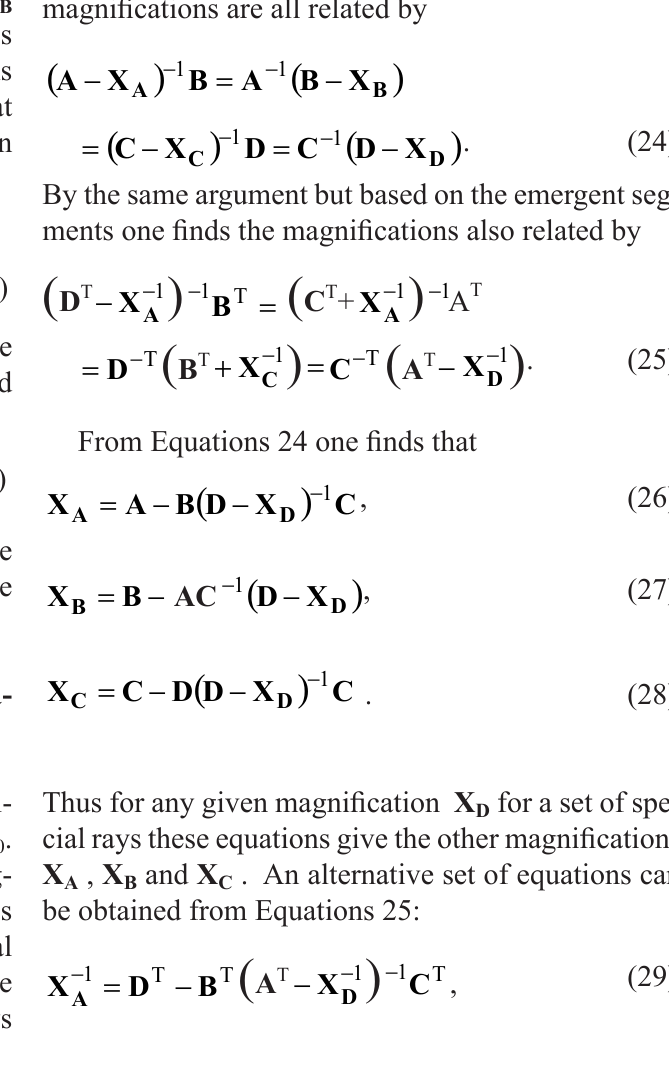
Table 1: Incident Z QO and emergent Z Q special characteristics for an optical system for the four generalized